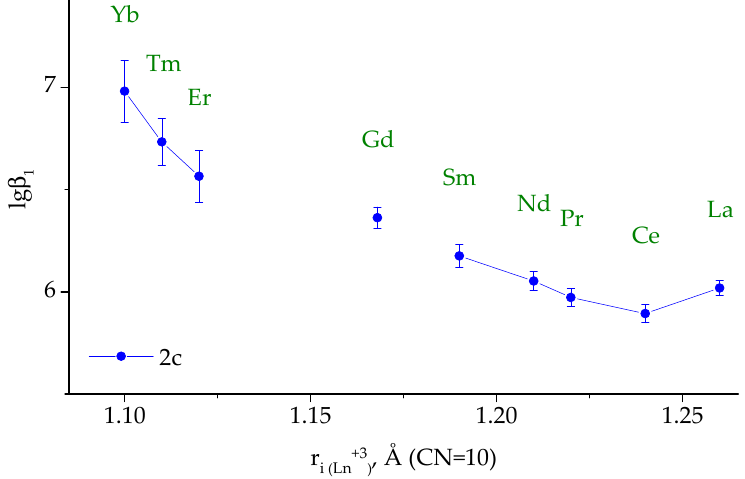
Figure 5. The stability constants (lg β ) of complexes of ligand 2c with Ln III as a function of ionic radii of ions. Table 4. Log β 1 values for the stability of trivalent lanthanides ions with 2c ligand in acetonitrile. Ln 3+ La